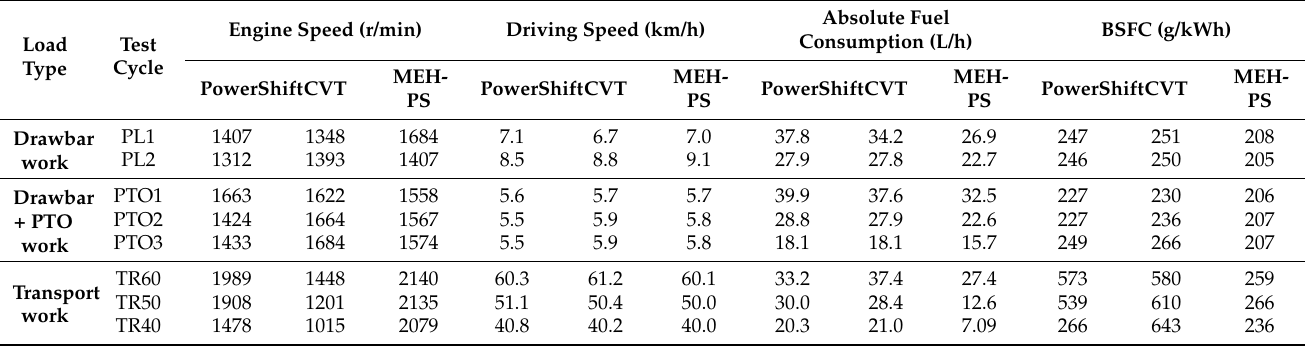
Table A2. Relevant data obtained from DLG test